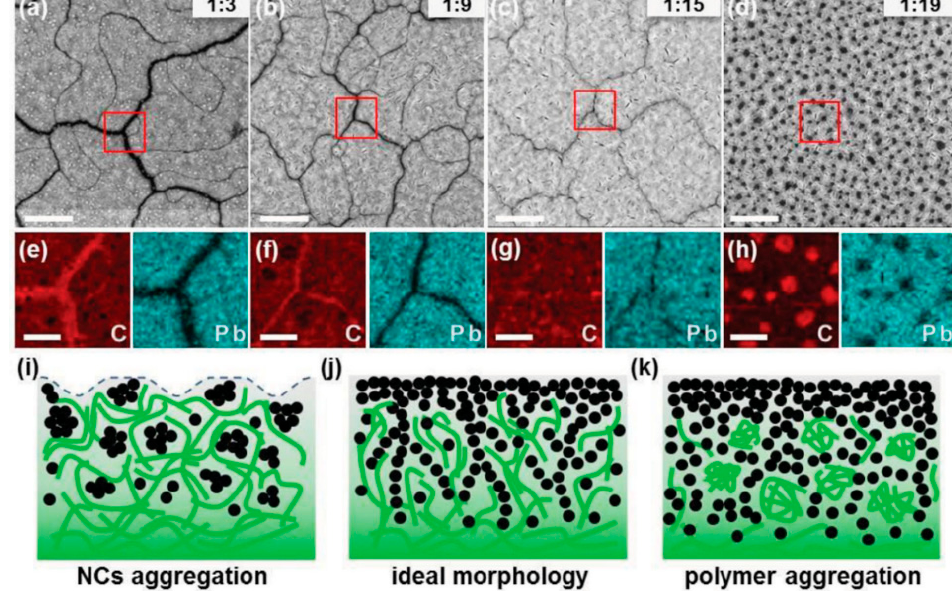
Figure 19. ( a – d ) Drift corrected HAADF-STEM images and ( e , f ) elemental mappings of C and Pb for PDTPBT/PbS 0.4 Se 0.6 blend films (before the deposition of pure NCs) with various weight ratios: ( a , e ) 1:3; ( b , f ) 1:9; ( c , g ) 1:15; ( d , h ) 1:19. The scale bars for ( a – d ) represent 2 μ m, ( e – h ) represent 500 nm. ( i – k ) Schematic depiction of the film morphology with increased NCs loading. ( i ) Low NC loading leads to the aggregation of NCs and incomplete coverage of NCs on bottom polymer. ( j ) Moderate blend ratio results in ideal film morphology. ( k ) Excess NC loading leads to the aggregation of polymers in NC matrix. Reprinted with permission from John Wiley and Sons: Advanced Materials Ref. [30],